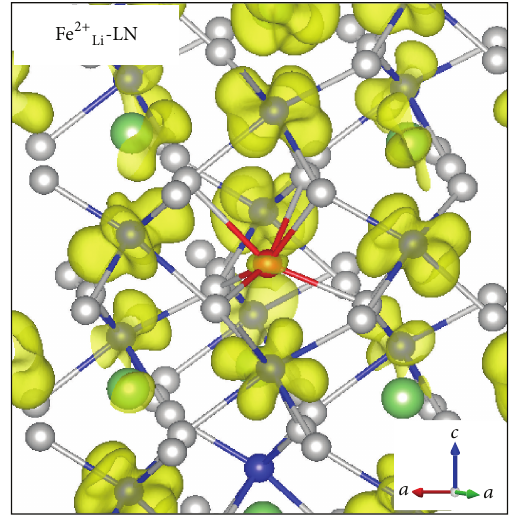
Figure 5: Wave function of the conduction band minimum (CBM) on the Γ point representing the Nb-4 d character, which is delocal- ized throughout the crystal.